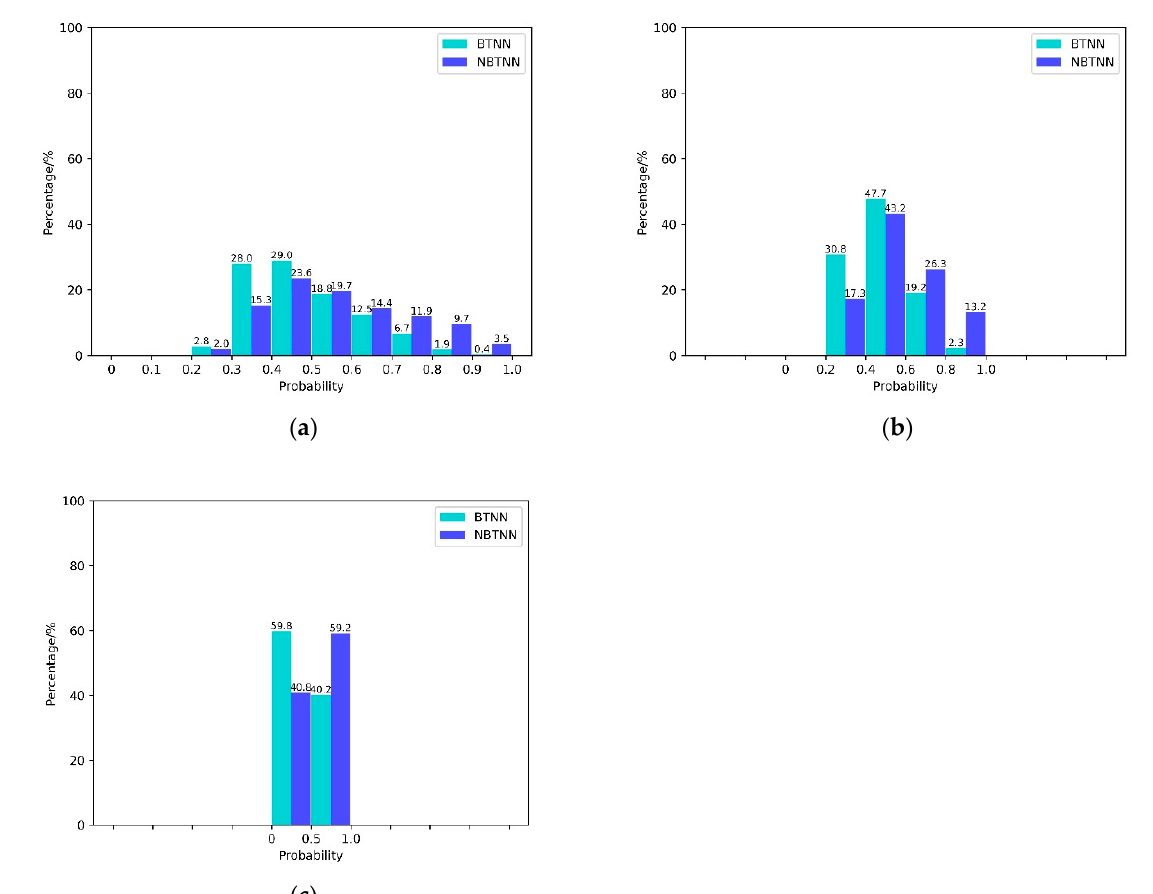
Figure 7. Comparison of percentage of misclassified samples in different predictive probability segments. ( a ) The interval of segments is 0.1 . ( b ) The interval of segments is 0.2 . ( c ) The interval of segments is 0.5 .